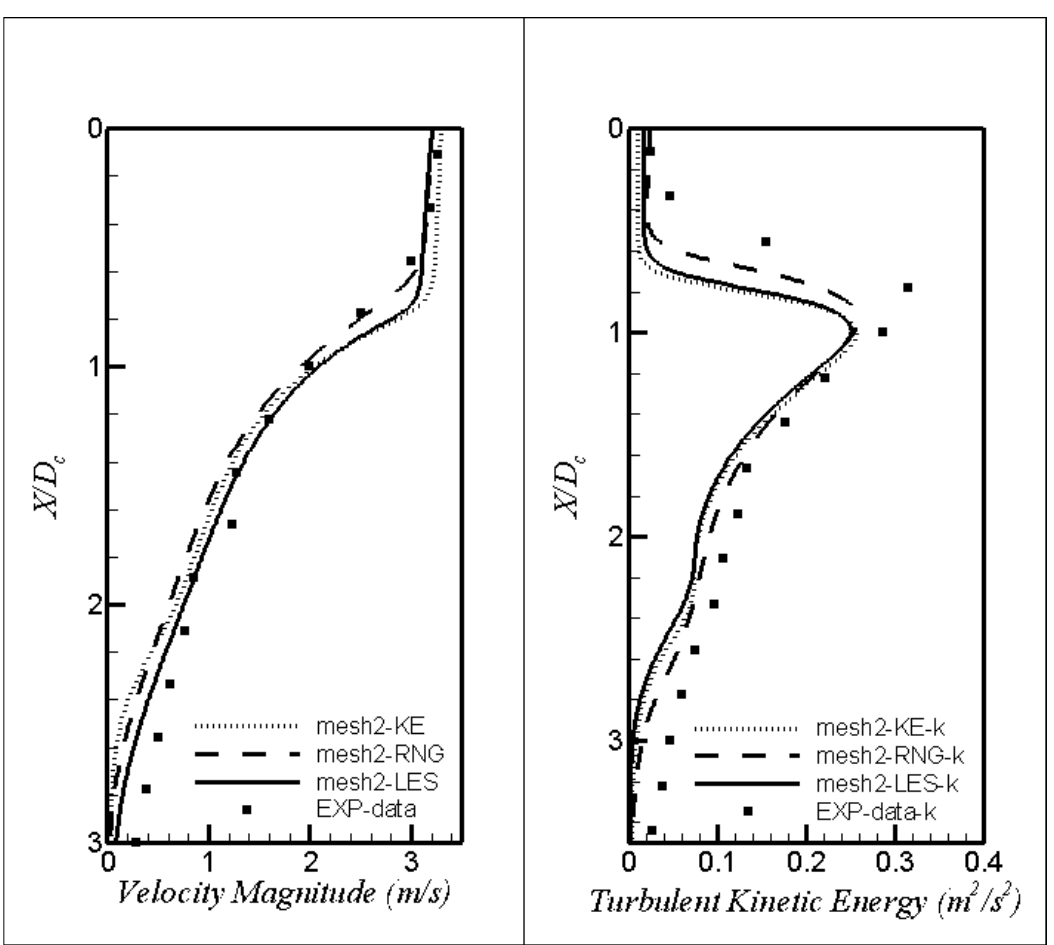
Figure 7: Computational (solid lines) and experimental (black squares) centre line velocity magnitude (m/s) and V =12 turbulence kinetic energy ( k ) [ q